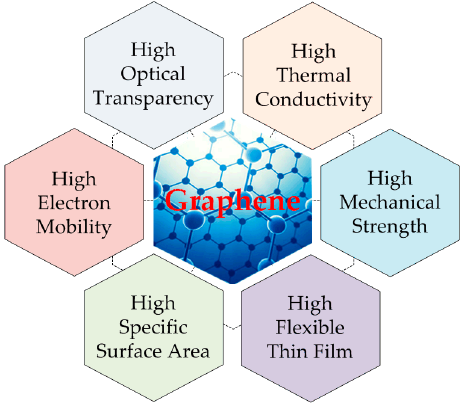
Figure 1. Allotropes of carbon: fullerene, nanotube, graphene, and graphite (reprinted with permission from [20]).